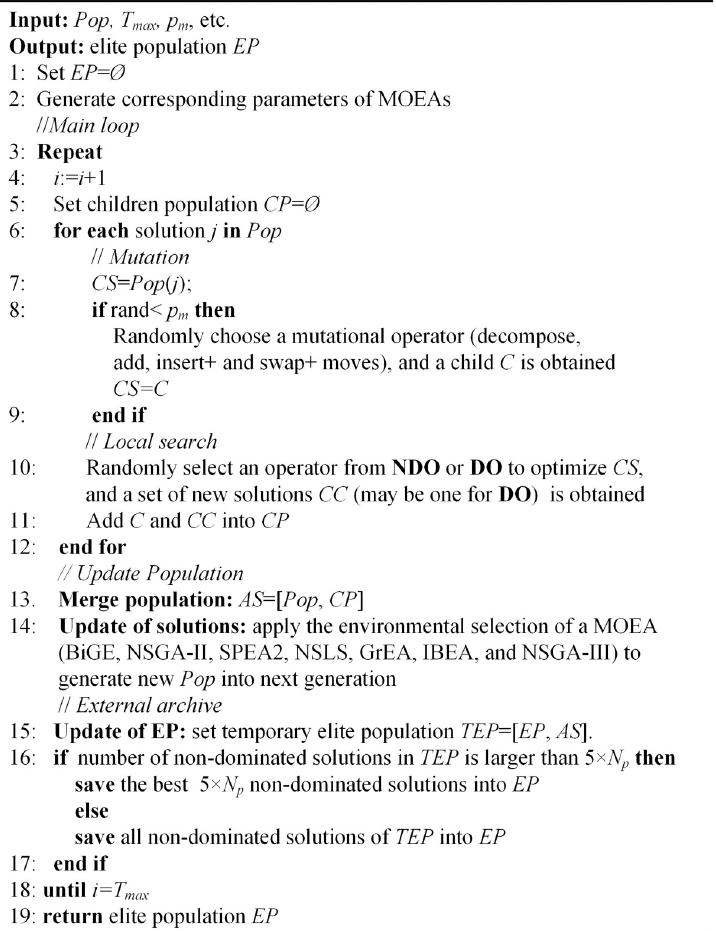
Fig 1. Algorithm 1. General framework of MOEAs for LRPLCCC.